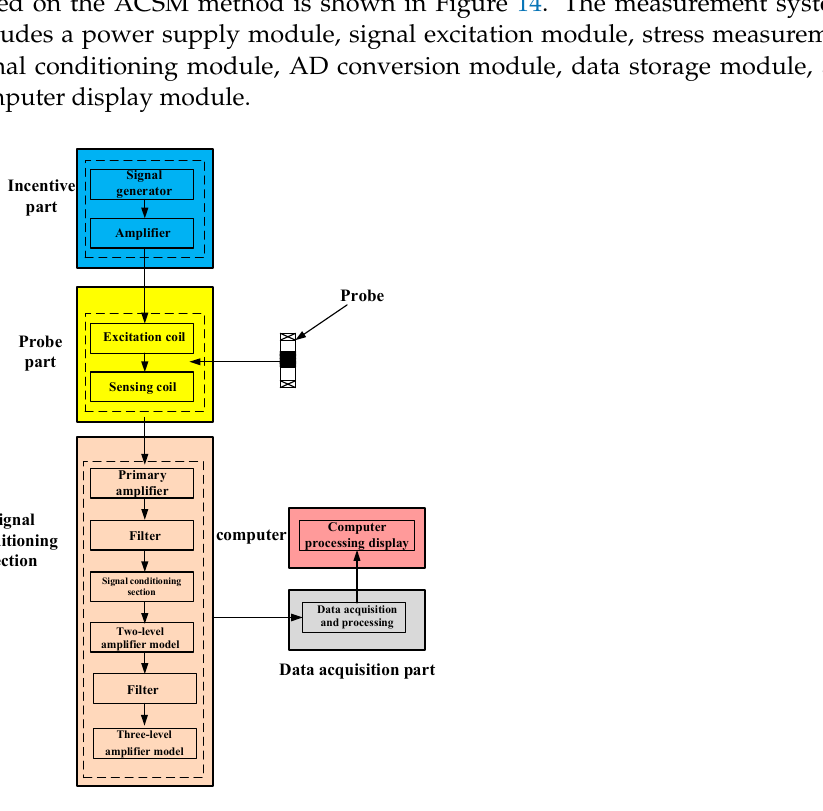
Figure 14. Structural block diagram of the internal stress measurement system for an oil pipeline.